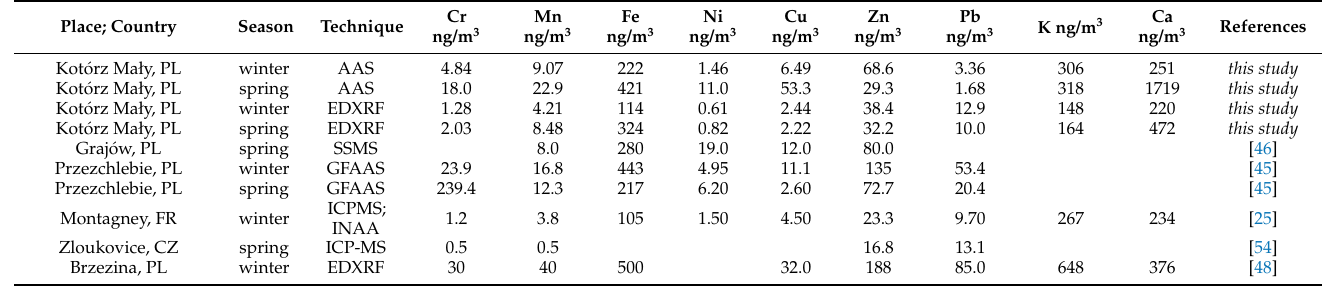
Table 6. The mean concentration of PM10-bound elements at various sites in the rural area.